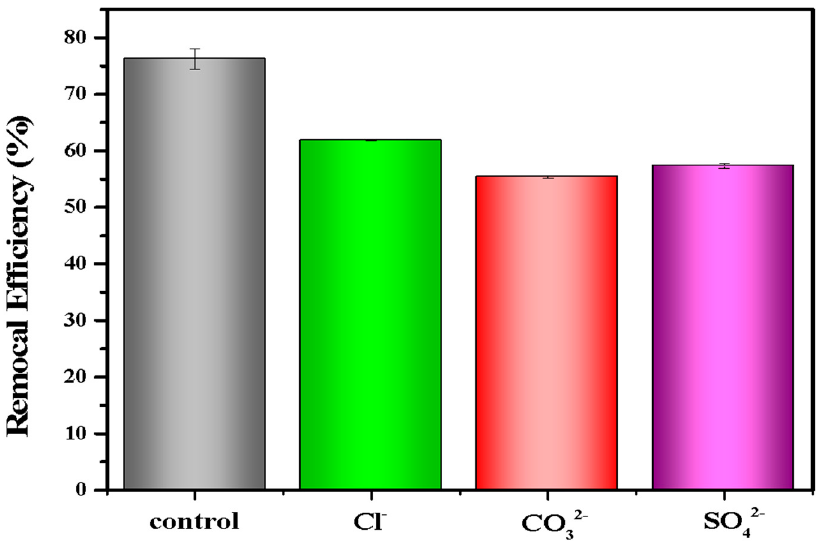
Figure 7. Effect of anions on phosphate recovery efficiency.